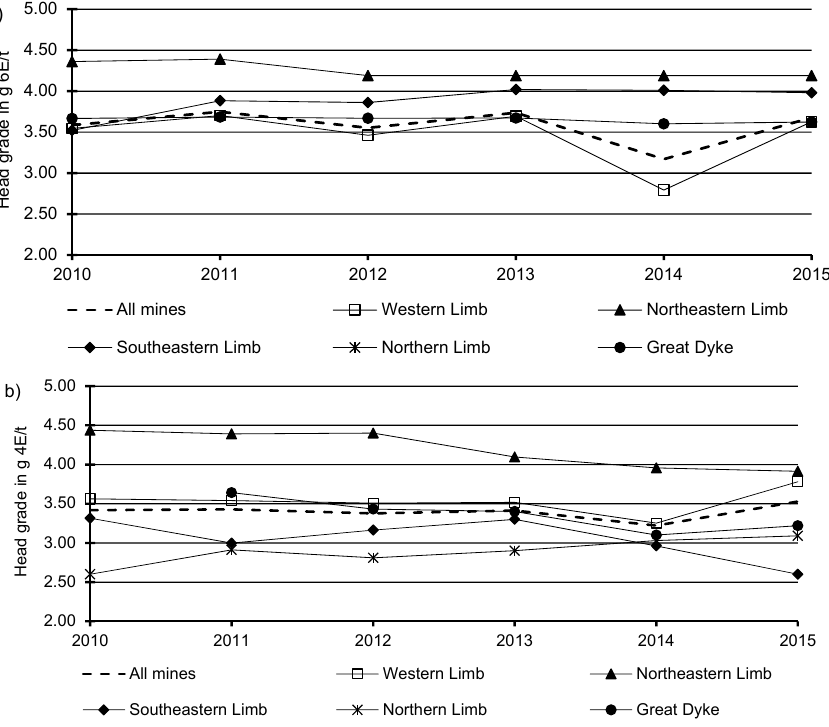
Figure 6. Head grade of processed ore from the Great Dyke and different sections of the Bushveld Complex in g 6E/t ( a ) and g 4E/t ( b ).